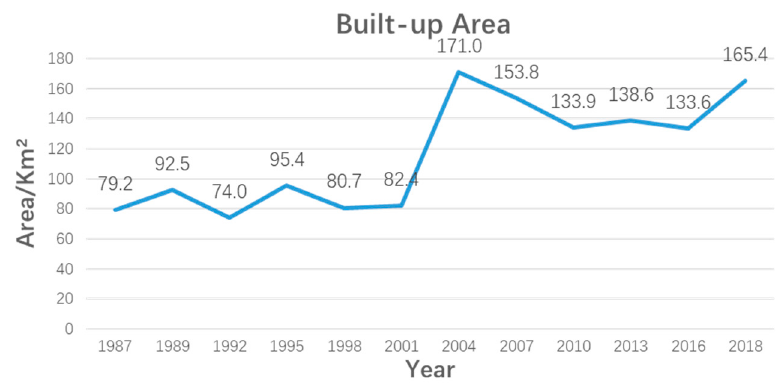
Figure 9. The built-up area of Mount Wutai from 1987 to 2018.